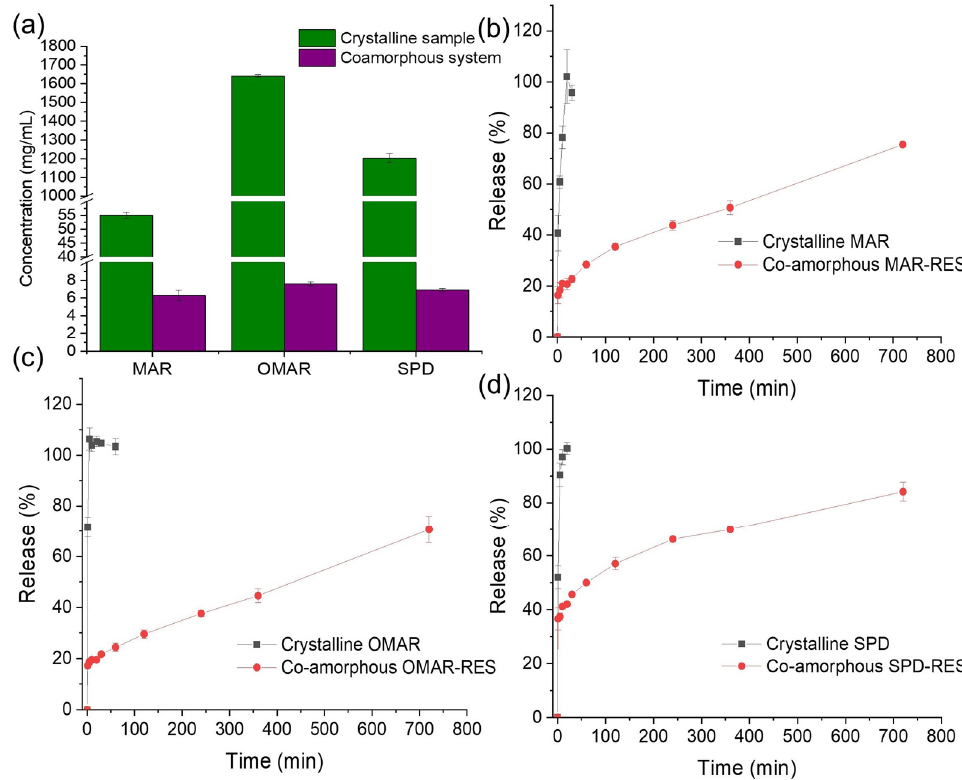
Figure 5. Equilibrium solubilities of matrine, oxymatrine, and sophoridine from their crystalline and co-amorphous forms ( a ); release profiles of MAR from crystalline MAR and co-amorphous MAR-RES ( b ); OMAR from crystalline OMAR and co-amorphous OMAR-RES ( c ); SPD from crystalline SPD, and co-amorphous SPD-RES ( d ) in pH 6.8 PBS at 37 ± 0.5 °C.